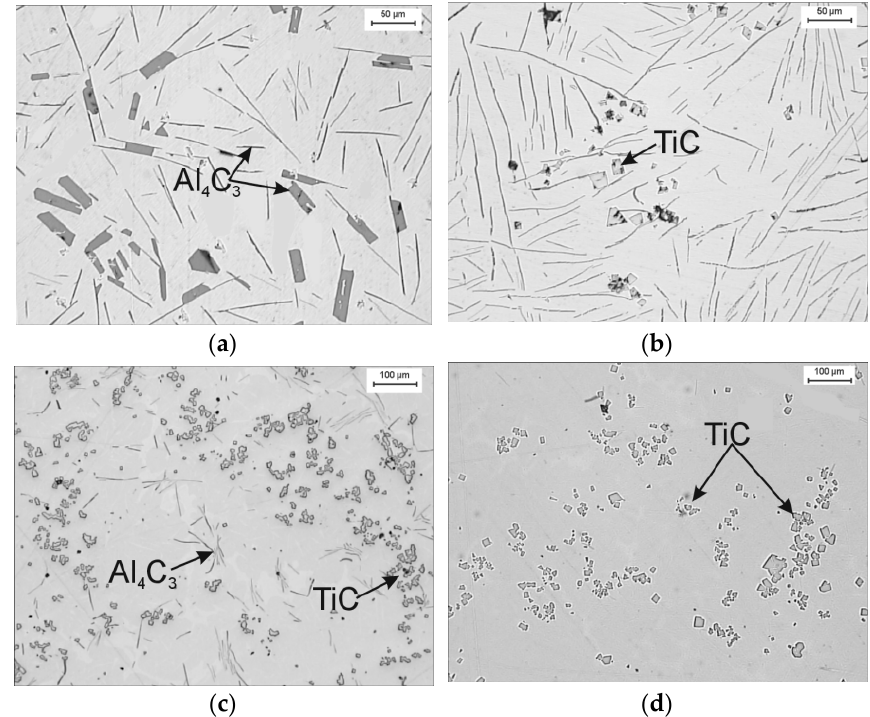
Figure 9. The microstructure of high-aluminum cast iron ( a ) and after addition of 1.3 %mass Ti ( b ), 2.7 %mass Ti ( c ), 5.4 %mass Ti ( d ); the structure subjected to spontaneous decomposition with different intensities ( a – c ), stable and durable structure ( d ).